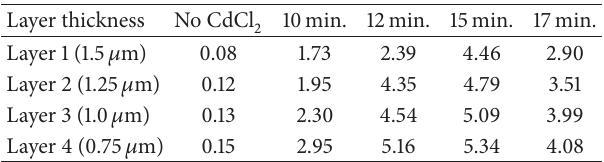
Table 2: Efficiencies for five samples processed at different CdCl 2 annealing times. Layer thickness No CdCl 2 10min. 12min. 15 min. 17min.